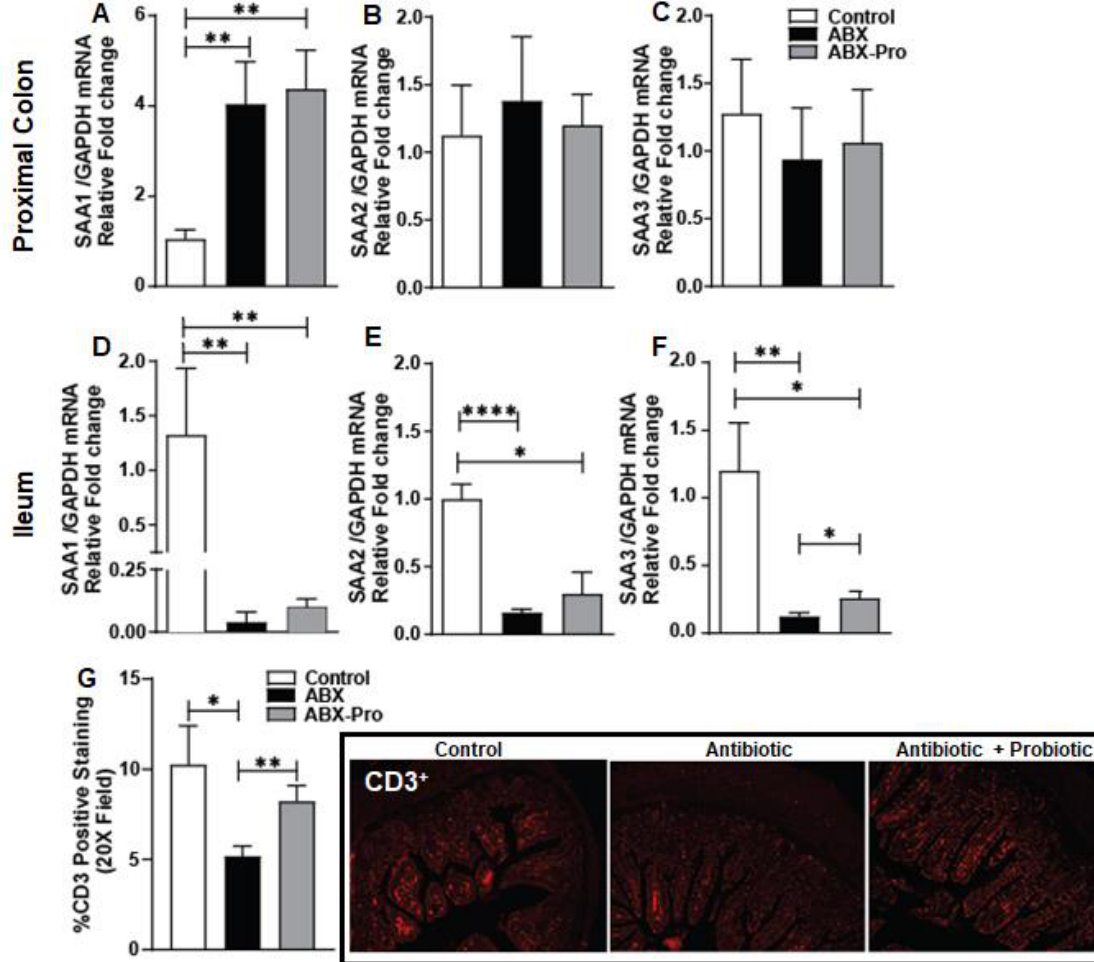
Figure 7. Serum Amyloid A and Immune Function. Mice were treated as described in Figure 1. At euthanasia, proximal colon and ileum were dissected and used to prepare RNA or fixed in formalin and embedded in paraffin. Relative mRNA expression of SAA-1, SAA-2, and SAA-3 in the ( A – C ) Proximal Colon and ileum ( D – F ) was detected by qRT-PCR. ( G ) CD3 was visualized by immunohistochemistry in sections of ileum fixed in formalin. Total object count was divided by total staining area to determine the percent CD3+ cells for each treatment group. All images were acquired using a 20× objective. Images are representative of at least replicate images captured per mouse in four mice per treatment group. Values represent mean ± standard error of the mean. * p < 0.05, ** p < 0.01, **** p < 0.0001.